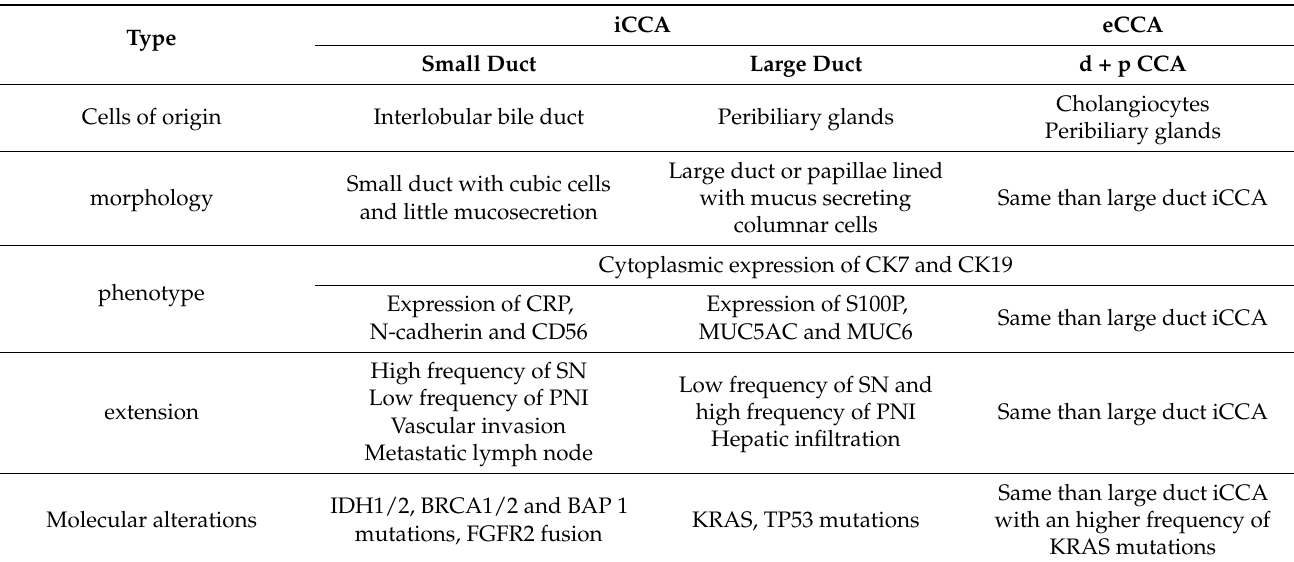
Table 1. Main charact é ristic of cholangiocarcinoma